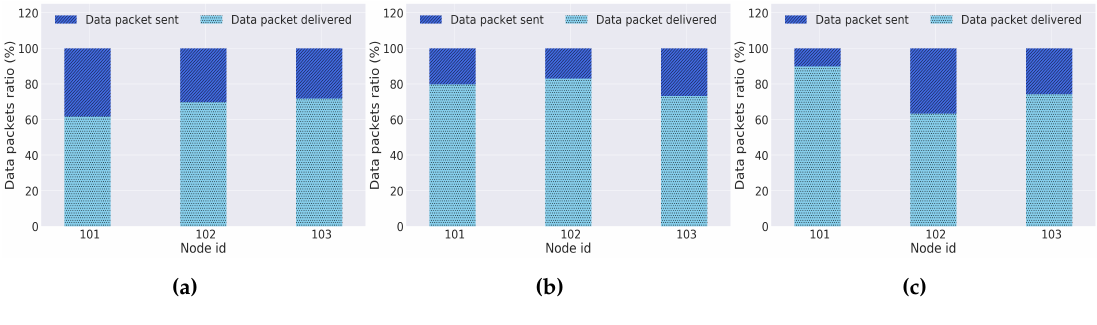
Figure 14. LoRa’s data packet delivery ( a ) Day 1; ( b ) Day 2; ( c ) Day 3.